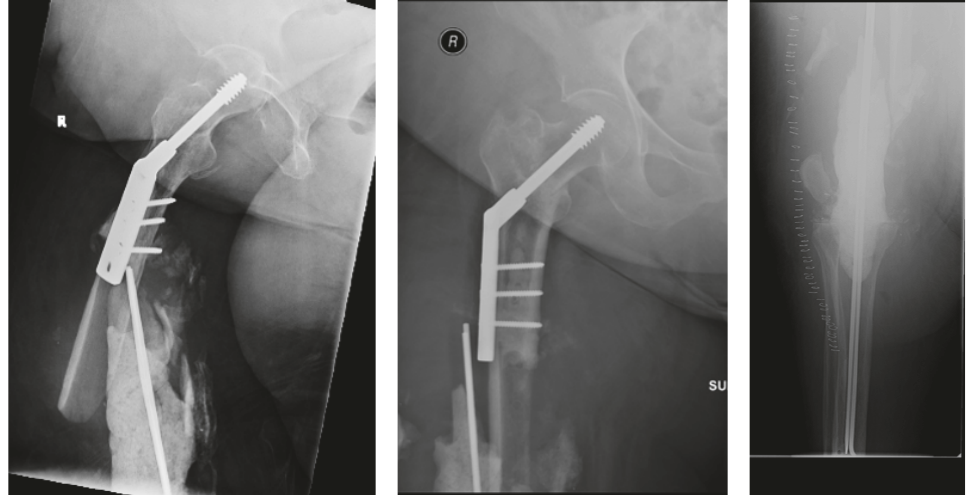
Figure 9: AP and lateral radiographs of right hip and lateral radiograph of right knee at presentation. Radiographs with antibiotic spacer over intramedullary K wire in tibia and extramedullary in femur. DHS in proximal femur.